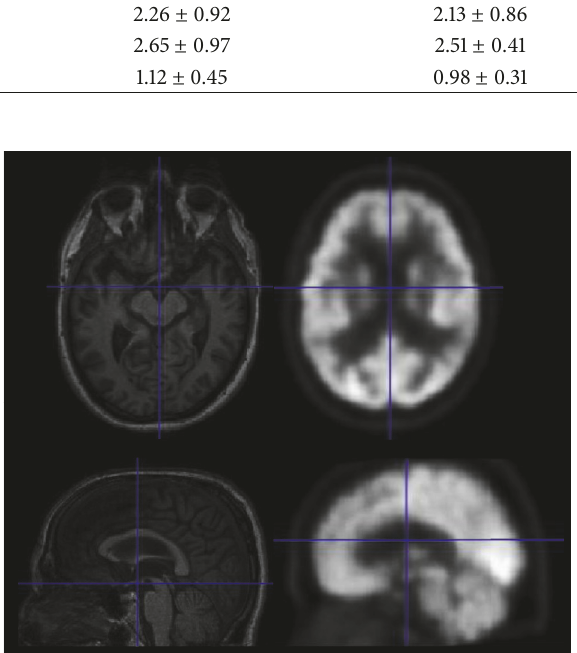
Figure 2: Selected regions of interest identified on PET images for cognitive classification